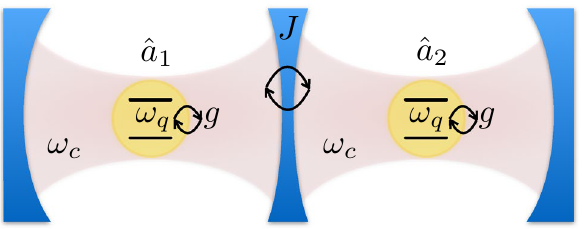
Figure 1. Sketch of the system. Two identical spatially separated optical resonators, with resonance frequency ω c , are weakly coupled together, each one of them ultrastrongly interacting with a single two-level system (qubit) with transition frequency ω q . The photon hopping rate J between the two resonators and the light–matter coupling strength g are